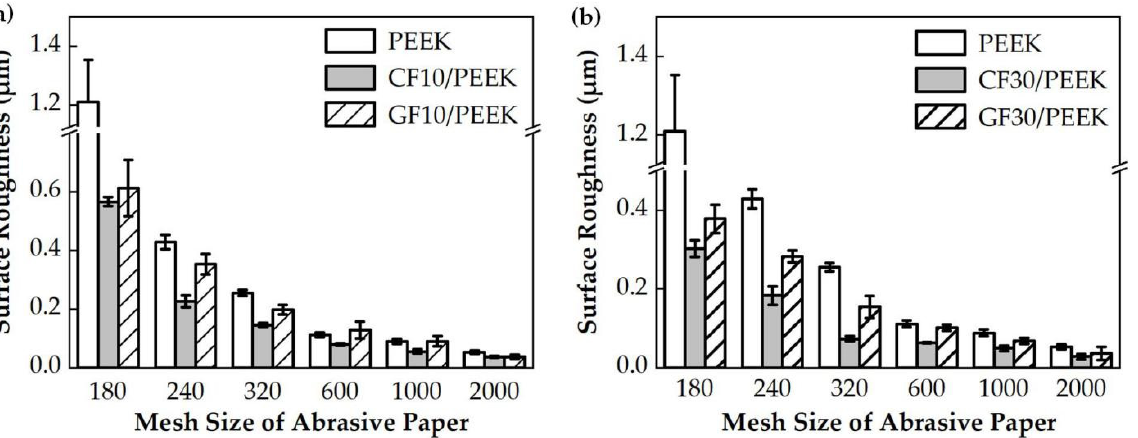
Figure 6. Comparative analysis on surface roughness of fiber types: ( a ) The surface roughness of the pure PEEK, CF10/PEEK, and GF10/PEEK, ( b ) the surface roughness of the pure PEEK, CF30/PEEK, and GF30/PEEK.